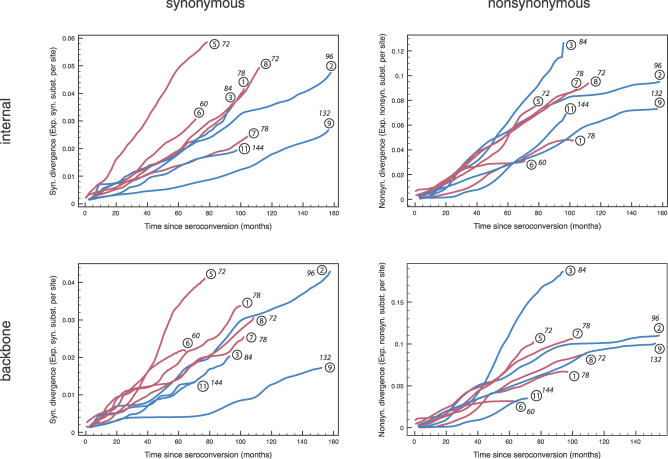
Mean Synonymous and Nonsynonymous Divergence for Internal and Backbone Branches over the Course of HIV Infection in Nine IndividualsPatients with moderate and slow disease progression, categorized by progression time less than or greater than seven years [17], are shown in pink and blue, respectively. Individual patient numbers from Shankarappa et al. [14] are shown in circles, and progression times for each patient are indicated in italics.